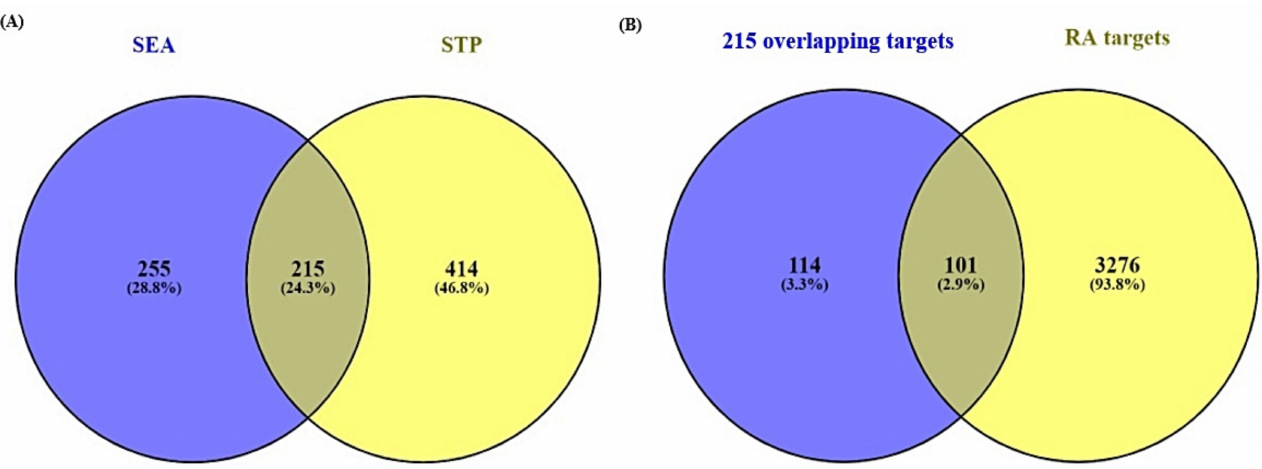
Figure 3. ( A ) The number of 215 overlapping targets between SEA (470 targets) and STP (629 targets). ( B ) The number of 101 final overlapping targets between 215 overlapping targets from two databases (SEA and STP) and RA associated with targets (3377 targets).